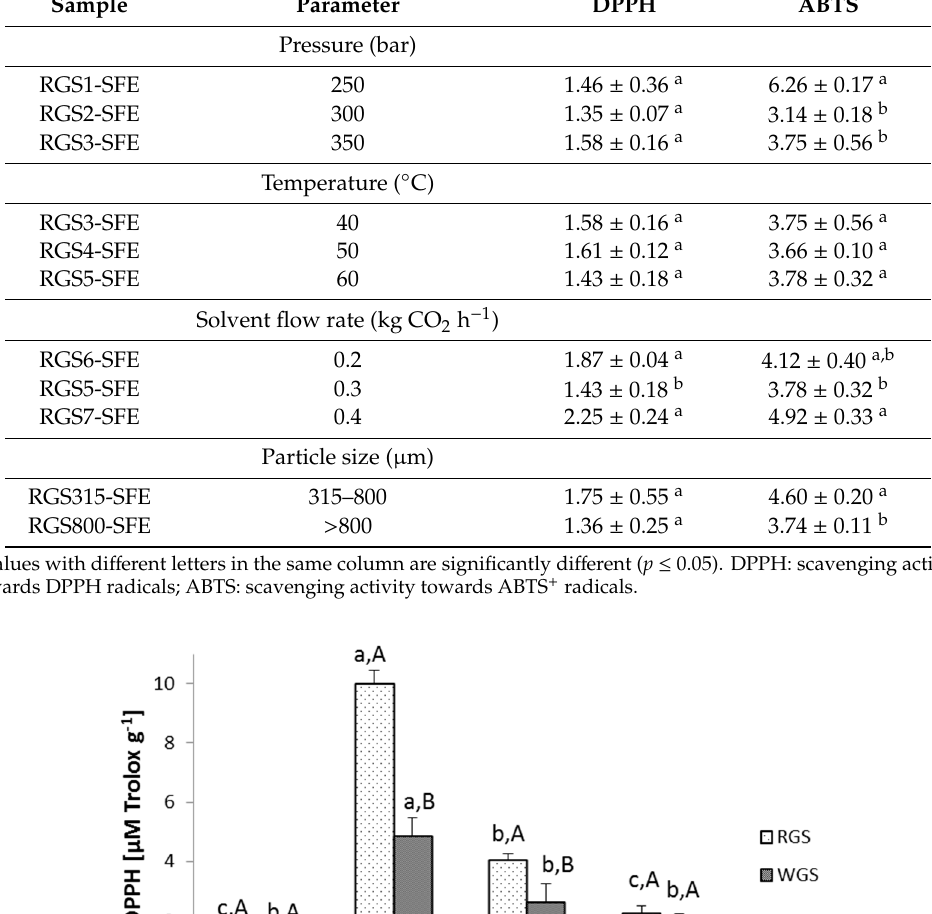
Table 6. Influence of SFE parameters on antioxidant activity of red grape seed oil ( µ M Trolox g − 1 ). Sample